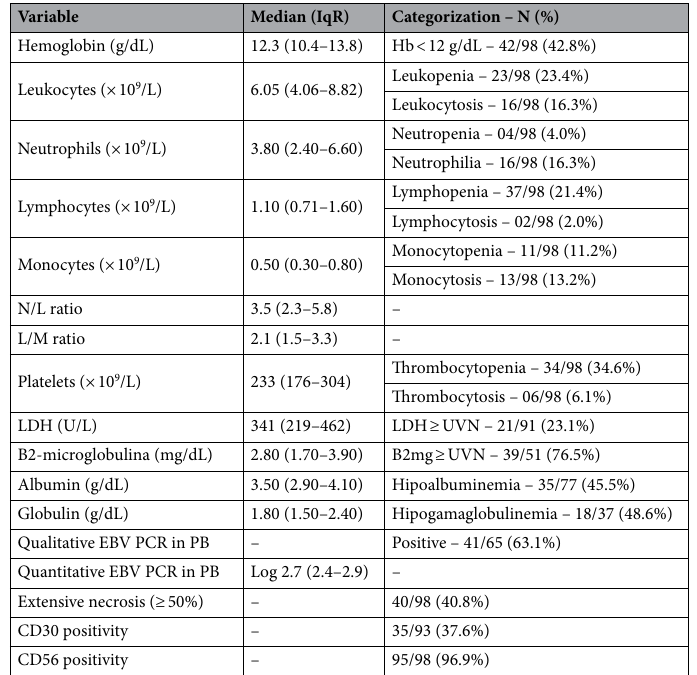
Table 1. Laboratory and histopathological characteristics for 98 ENKTL Brazilian patients. IqR Interquartile interval, Hb Hemoglobin, N/L Neutrophils/lymphocytes ratio, L/M Lymphocytes/monocytes ratio, LDH